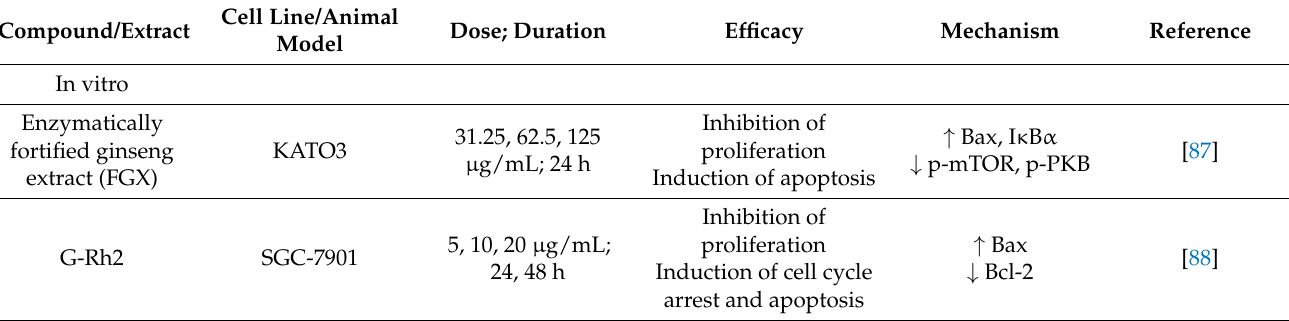
Table 5. Panax ginseng and its metabolites against gastric